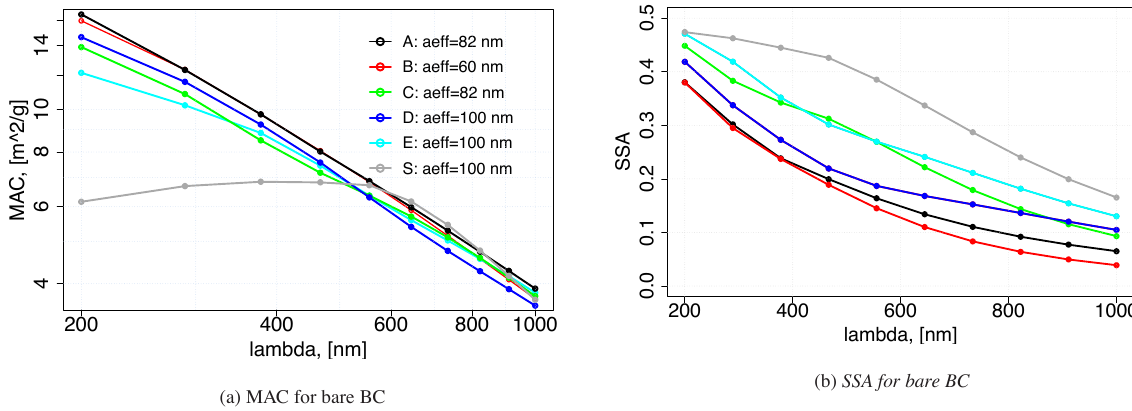
Fig. 3. (a) MAC in log-log scale and (b) SSA for five bare BC aggregates (cases A–E) and one homogeneous sphere approximation with equivalent volume of case D and E (HSA, case S). For a fixed number of the same sized monomers, compact aggregates exhibit lower MAC and higher SSA than lacy aggregates. All the computed optical values are averaged over 1000 target orientations and 9 scattering planes and satisfy the condition | m | kd < 0 . 3. We use m BC = 1 . 95 − 0 . 79 i and ρ BC = 1 . 8gcm − 3 . The spectral resolution is 100nm. The characteristics of the bare BC are described in Table 1 and Fig.